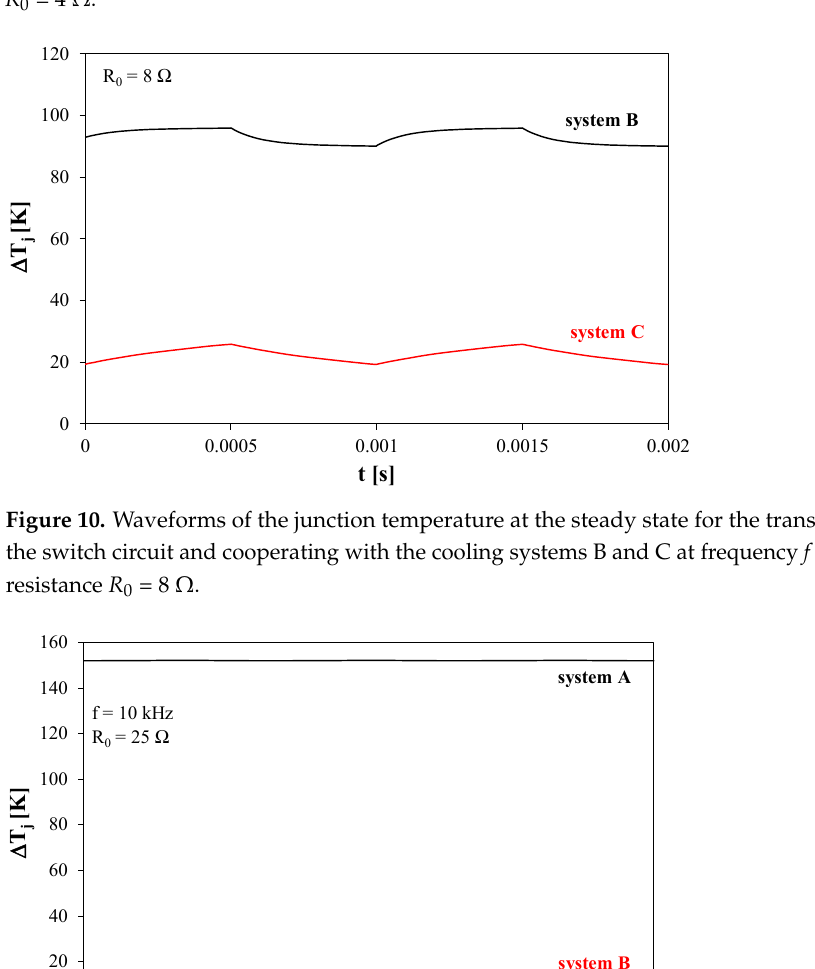
sistance R 0 = 4 Ω . R 0 = 4 Ω .